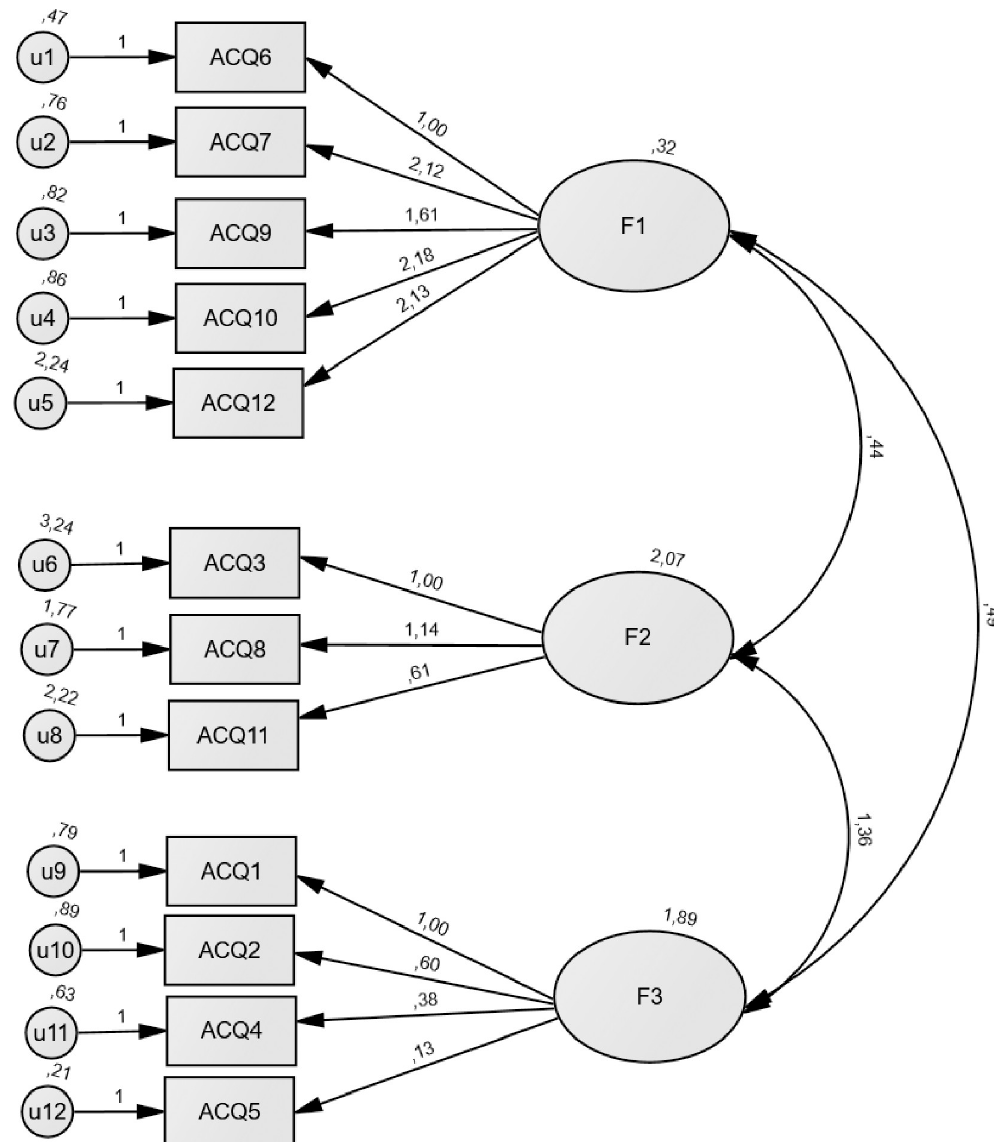
Fig 1. Confirmatory factor analysis for the ACQ-SR-N-PT F1 -Emotionality- includes items 6, 7, 9, 10, and 12; F2 -Purposefulness- includes items 3, 8, and 11; F3 –Compulsivity includes items 1, 2, 4, and 5 (N =